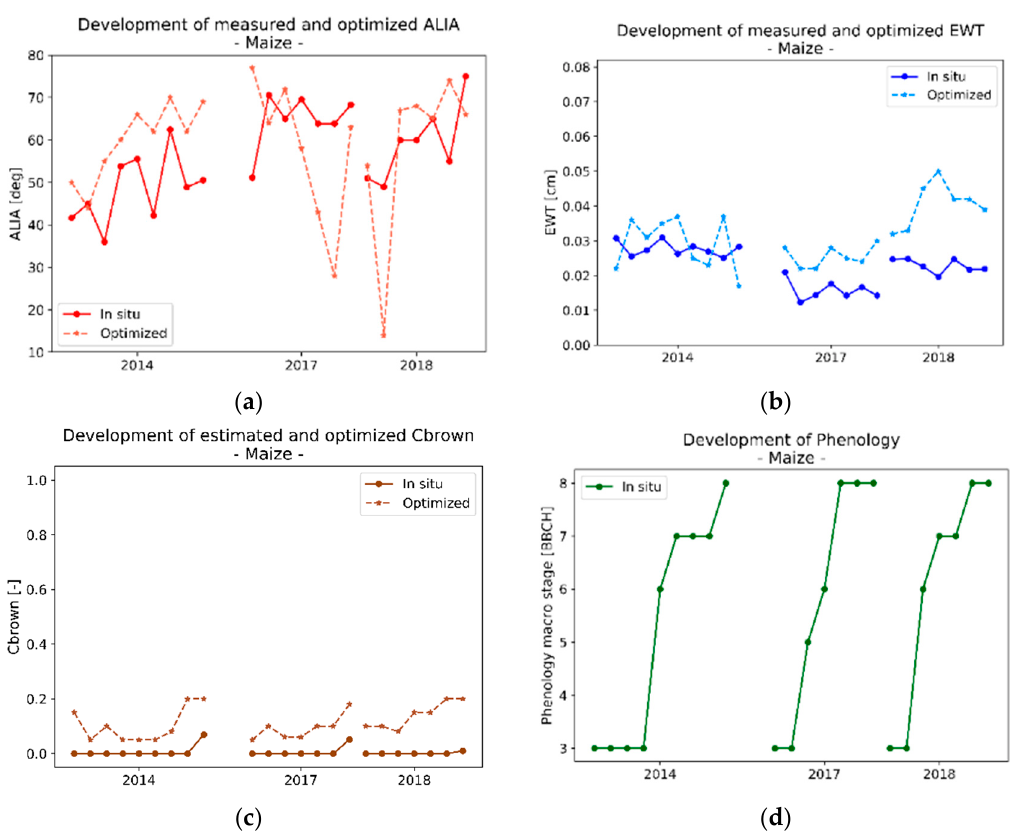
Figure 10. All values ALIA ( a ), EWT ( b ) and C brown ( c ) and Phenology ( d ) for the three silage maize field campaigns of 2014, 2017 and 2018. In situ measurements ( a & b ) and estimations ( c ) are shown as solid lines; optimized parameters are drawn with a dashed line style. Table 6. Distance measures between in situ observations of ALIA, EWT and C brown vs. optimized values in the manual fitting process for silage maize.